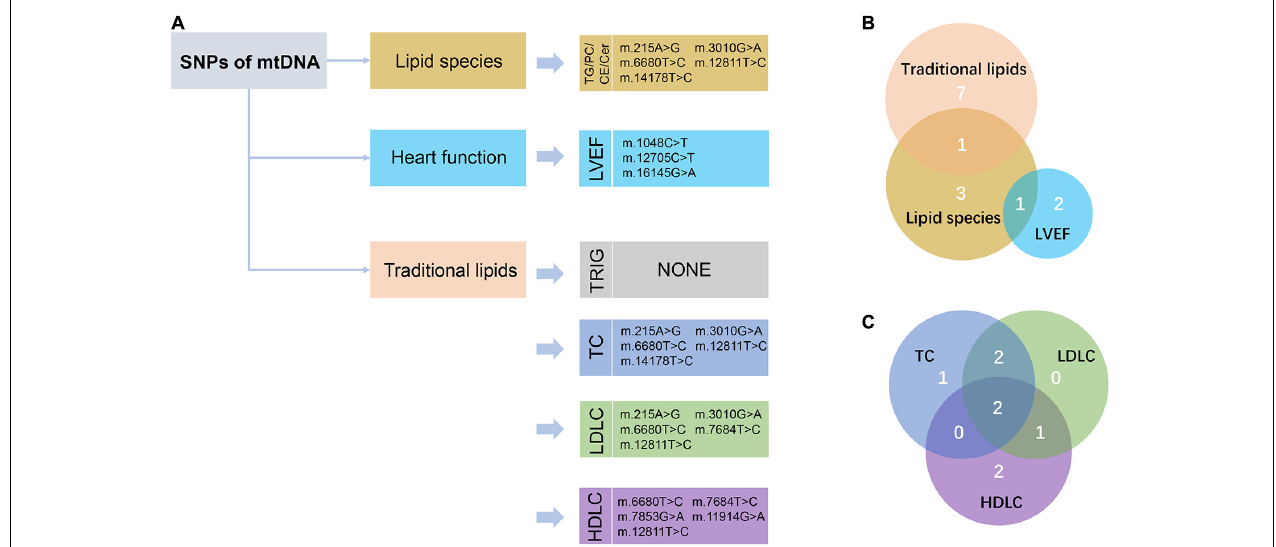
FIGURE 3 | Schematic view of the association analyses results. (A) The nominally significant ( P < 0.05) SNPs of mtDNA with lipid species, traditional lipids, and heart function were presented. TG, triacylglycerol; PC, phosphatidylcholines; CE, cholesteryl esters; Cer, ceramides; LVEF, left ventricular ejection fraction; TRIG, triglyceride; TC, total cholesterol; LDLC, low-density lipoprotein cholesterol; HDLC, high-density lipoprotein cholesterol. (B) Venn diagram showed the intersection of these nominally significant SNPs in lipid species, traditional lipids, and LVEF. (C) Venn diagram showed the intersection of the nominally significant SNPs in the traditional lipids, including TC, LDLC, and